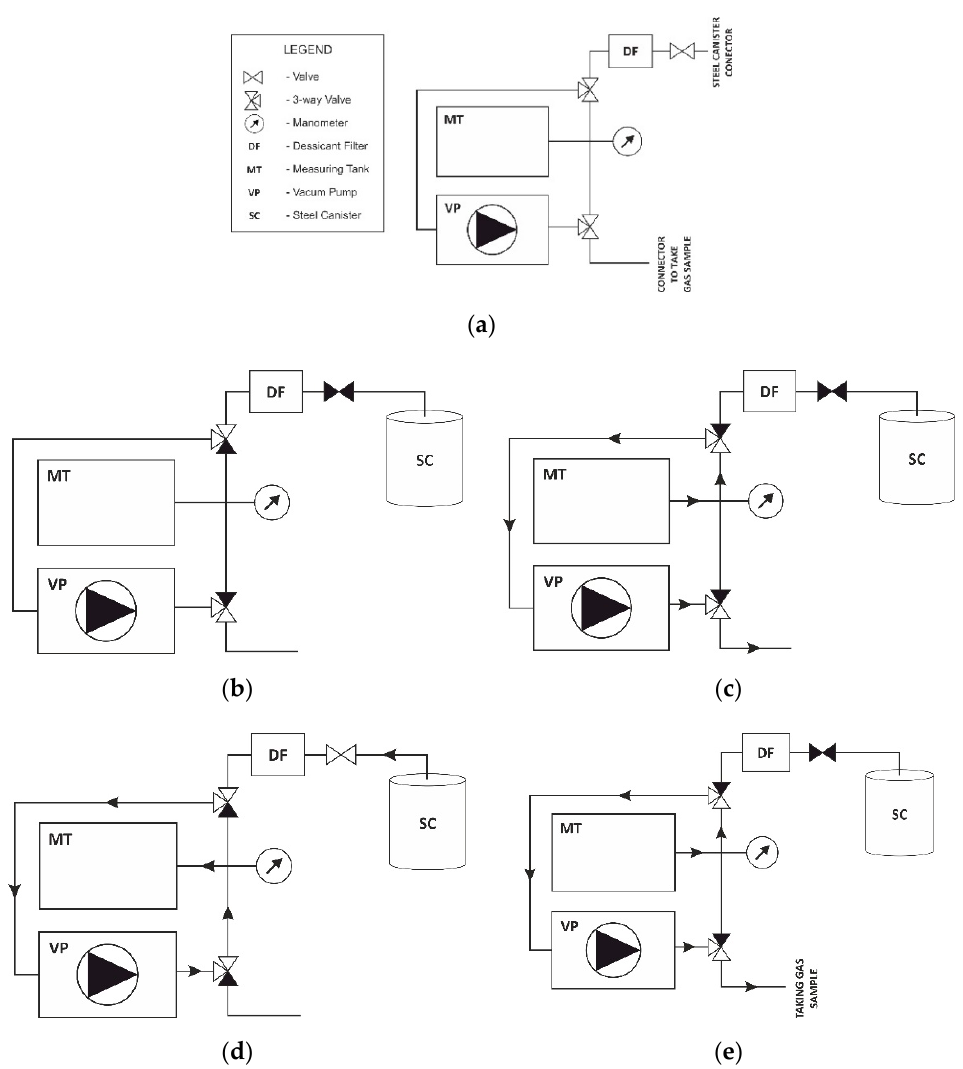
Figure 8. Schematic diagram of equipment used for degassing coal samples: ( a ) components of degassing apparatus; ( b ) connecting a steel canister with a coal sample; ( c ) creating vacuum in the measuring system; ( d ) degassing a coal sample; ( e ) taking a gas sample for chromatography